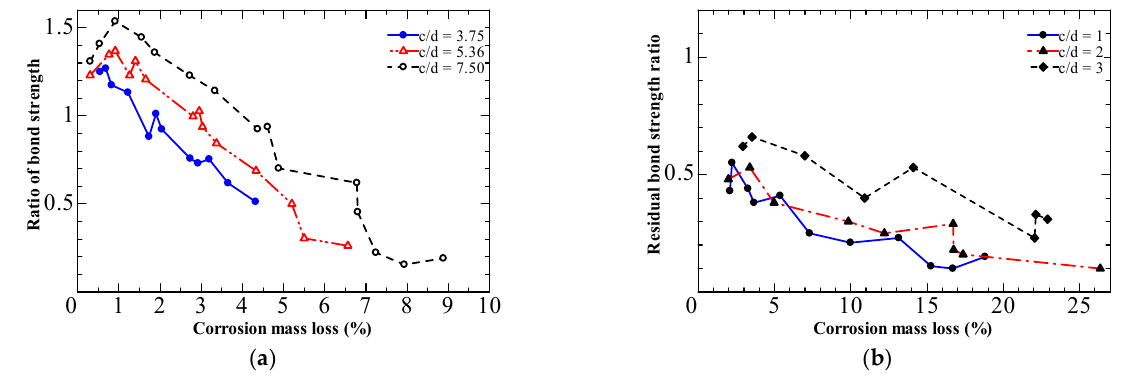
Figure 15. Influence of the cover-to-diameter ratio on bond deterioration: ( a ) Al-Sulaimani et al. [31]; ( b ) Amleh et al. [32].